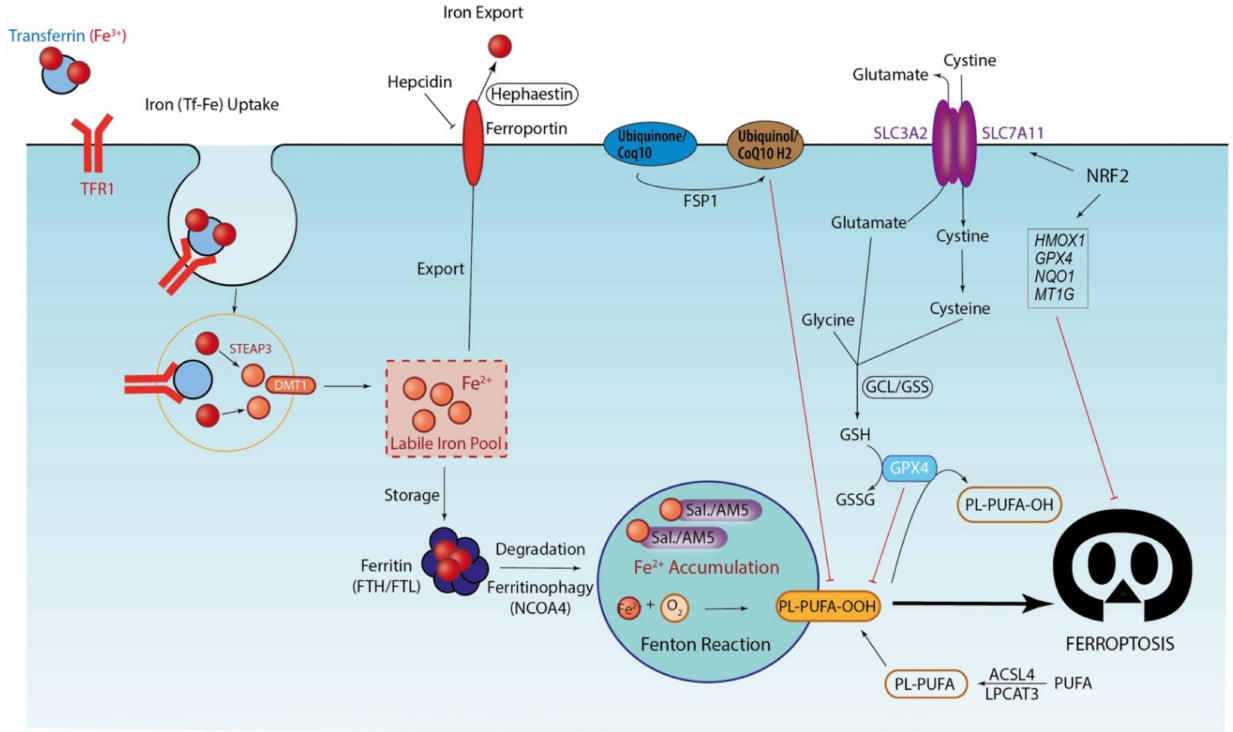
Figure 2. Molecular interactions involved in the induction and regulation of ferroptosis. Decisive characteristics of ferroptosis resulting from phospholipid peroxidation (LOOH) are: (1) its dependence on iron, under the Fenton reaction (Fe 2+ + H 2 O 2 → Fe 3+ + OH + OH − ), which can be caused by: (i) the increased expression of key players for iron uptake, including iron-binding transferrin receptors (TfR1/TFRC), or even DMT1 or STEAP3 that directly bind iron; (ii) the degradation of ferritin (FTH/FTL complex), which is the iron-storage protein, involving ferritinophagy, an NCOA4- dependent autophagic process to release iron in the lysosome; (iii) lysosomal iron sequestration, as induced by Sal./AM5; and iv) the hepcidin-mediated inhibition of ferroportin expression, which is involved by the export of iron and thus promotes iron retention. (2) Disturbances in the GSH/GPX4 axis that ensures the redox balance; or in the same order, disturbances in the level of CoQ10 (a byproduct of the mevalonate pathway) with its FSP-1 reductase that were recently found to prevent the peroxidation of membrane lipids. ACSL4 and LPCAT3, which are involved in the esterification of PUFA in membrane phospholipids (PL-PUFA), are key actors in sensitivity to ferroptosis. NRF2, the master antioxidant regulator, is also able to prevent ferroptosis by activating the expression of a large number of genes encoding ferroptosis inhibitors including NQO1, HMOX1, FTH, GPX4, system X c − /SLC7A11, the GCL/GSS enzymes involved in the GSH synthesis, and lastly MT1 G. Arrowhead or stop lines indicate promotion/activation or inhibition,